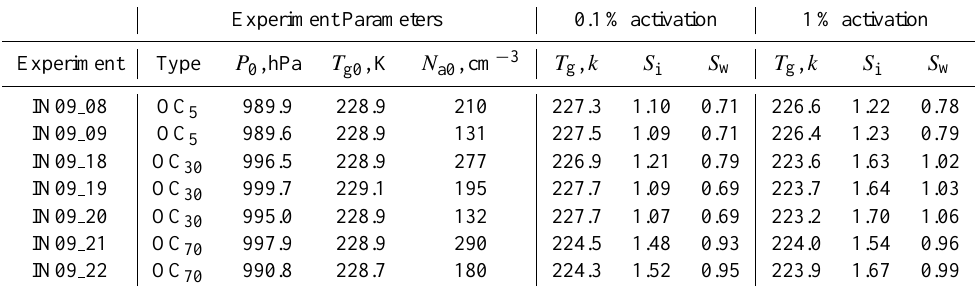
Table 1. Parameters of AIDA ice cloud simulations. IN09 experiments were performed using CAST propane flame soot. P 0 is the AIDA pressure before pumping, T g0 the AIDA gas temperature before pumping, N a0 the AIDA aerosol number concentration before pumping. The onset of freezing for 0.1% and 1% of the aerosol population becoming ice active is given as a function of the AIDA gas temperature ( T g ) and the saturation ratio with respect to ice and water ( S i and S w